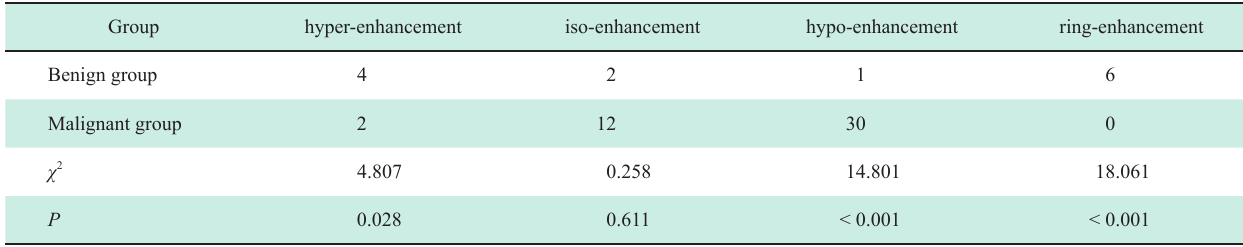
Table 1 Enhancement pattern of 57 thyroid nodules